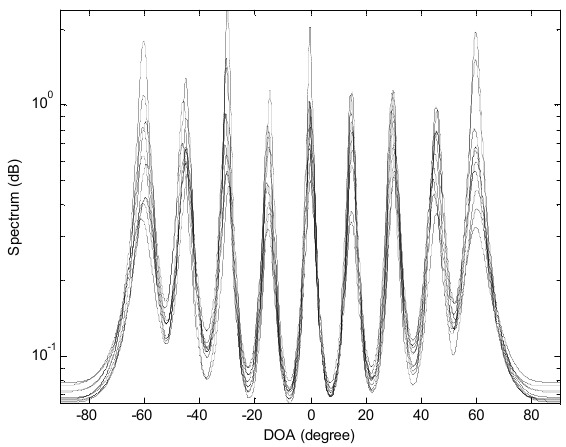
Figure 2. Mixed sources direction-of-arrival (DOA) spectra obtained with the proposed method. K = 9, 2 M + 1 = 9. 10 independent trials are